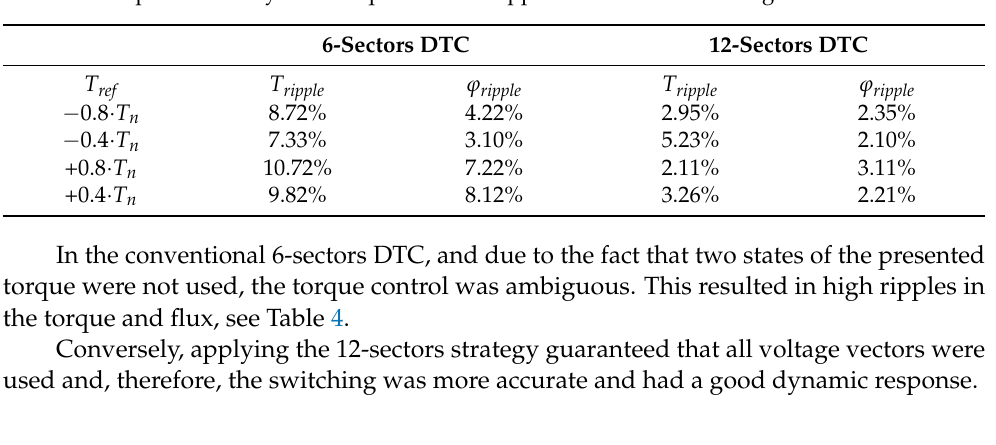
Table 4. Comparative analysis of torque and flux ripples for different DTC